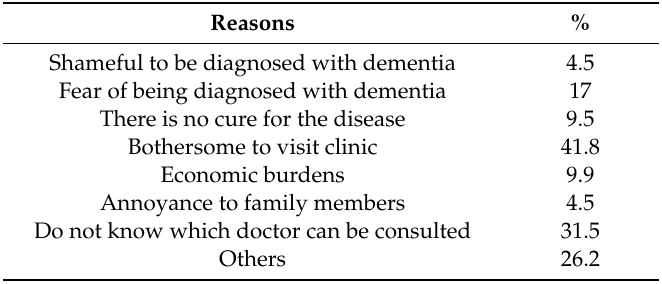
Table 4. The reasons of unwilling to undergo regular dementia screening.